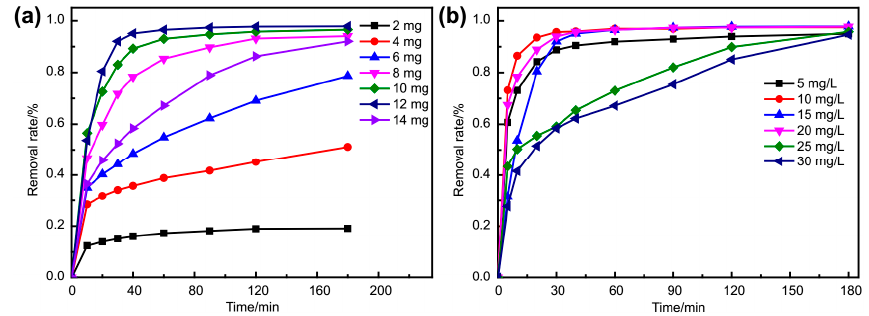
Figure 8. The influence of ( a ) adsorbent usage and ( b ) MB concentration.